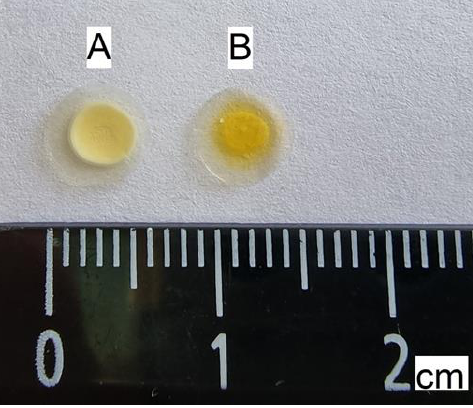
Figure 1. A photograph of the BChE-based multicomponent reagent. A — starch gel; B — gelatin gel. BChE incorporated in the starch and gelatin gels retained its activity (Figure 2). The preparation based on gelatin gel showed greater activity compared to the starch gel prepa- ration, with the S-BCh-I hydrolysis rate being 30% higher (Figure 2). Another finding was that DTNB immobilization in the preparations did not result in any significant loss of activity of the preparations based on either starch or gelatin gel (Figure 2). Keeping